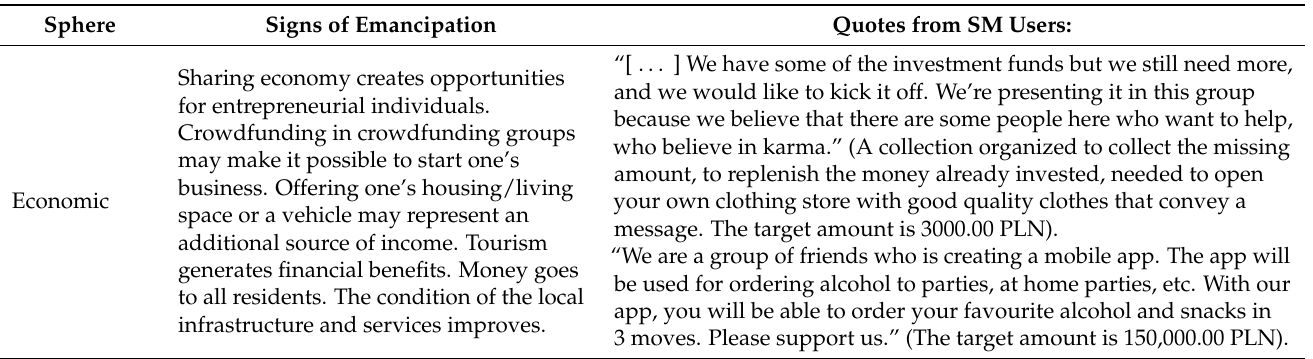
Table 6. Spheres of emancipation of local communities resulting from involvement in activities within the sharing economy. Sphere Signs of Emancipation Quotes from SM Users: Sharing economy creates opportunities for entrepreneurial